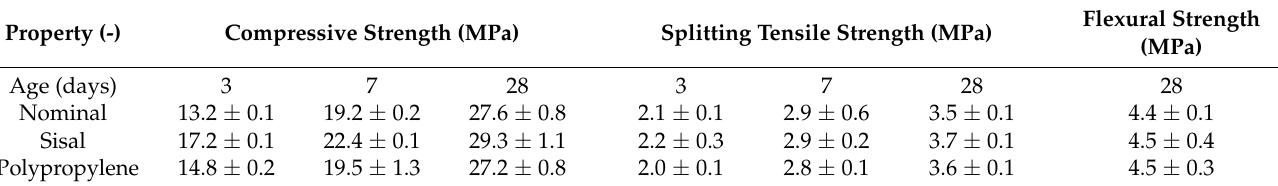
Table 3. Mechanical properties through destructive testing.